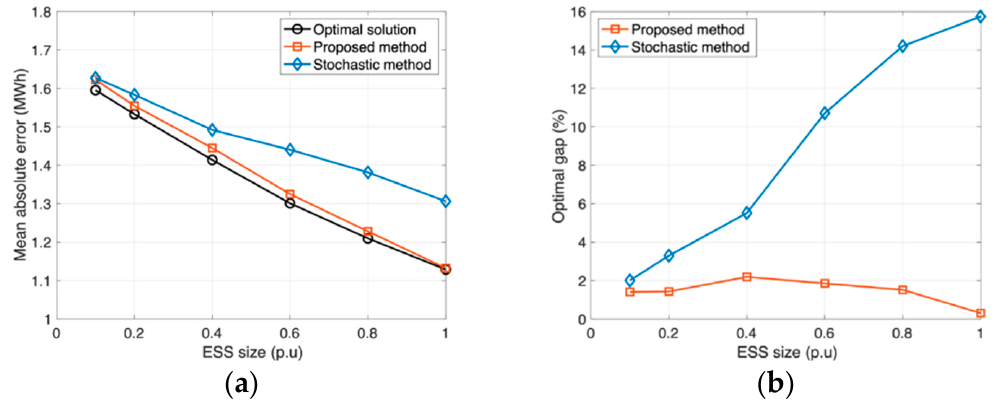
Figure 3. Mean absolute error (MAE) comparison between the optimal solution, proposed method, and stochastic method. ( a ) Mean absolute error; ( b ) Optimal gap. and stochastic method. ( a ) Mean absolute error; ( b ) Optimal